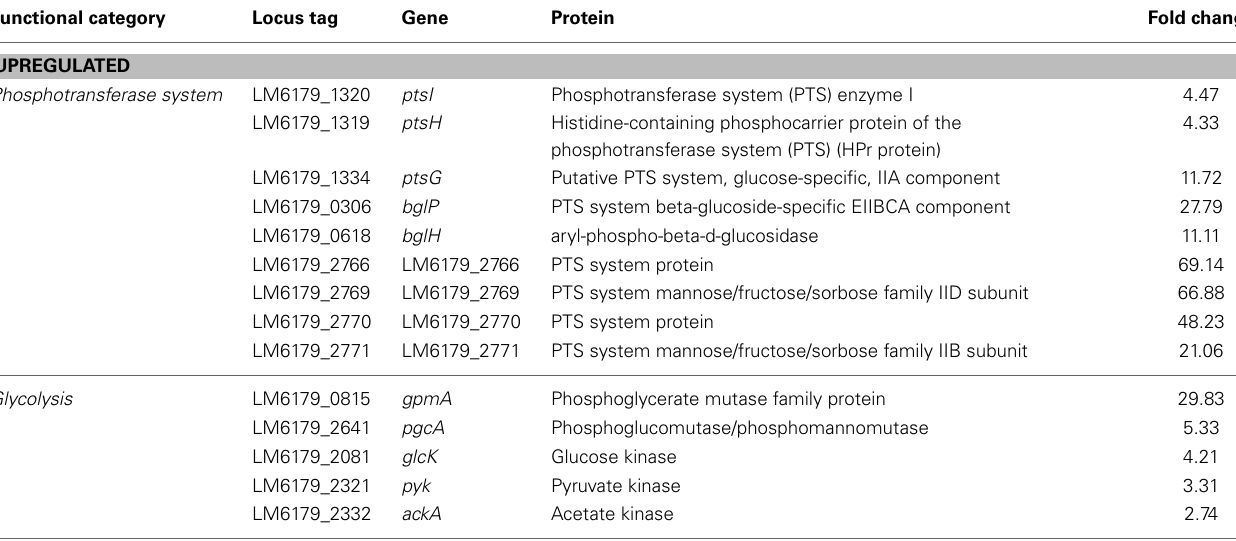
Table 6 | Phosphotransferase system and glycolysis genes which change in regulation following exposure of strain 6179 to BZT. Functional